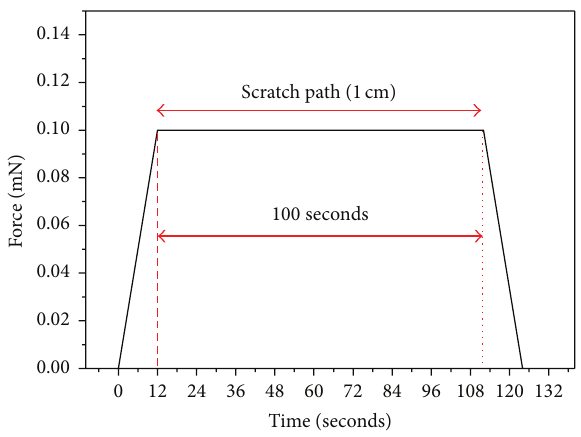
Figure 1: The loading-unloading curve in scratching